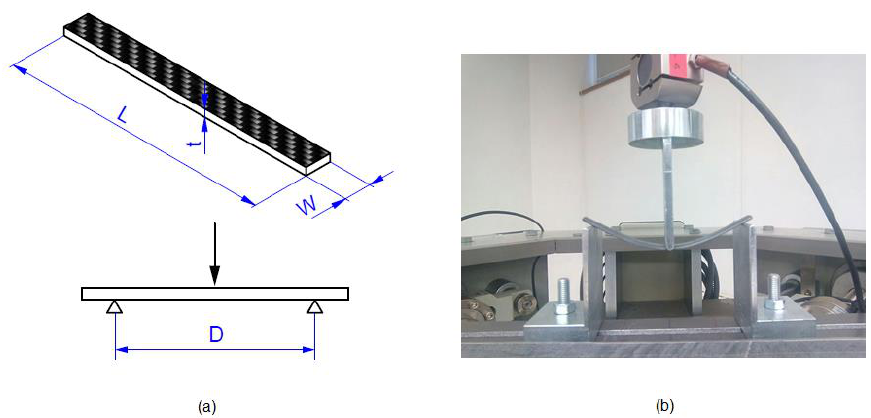
Figure 4. Details of the 3-point bending test. ( a ) Span sample dimension ( D = 130 mm) and ( b ) experimental setup according to ASTM D7264.